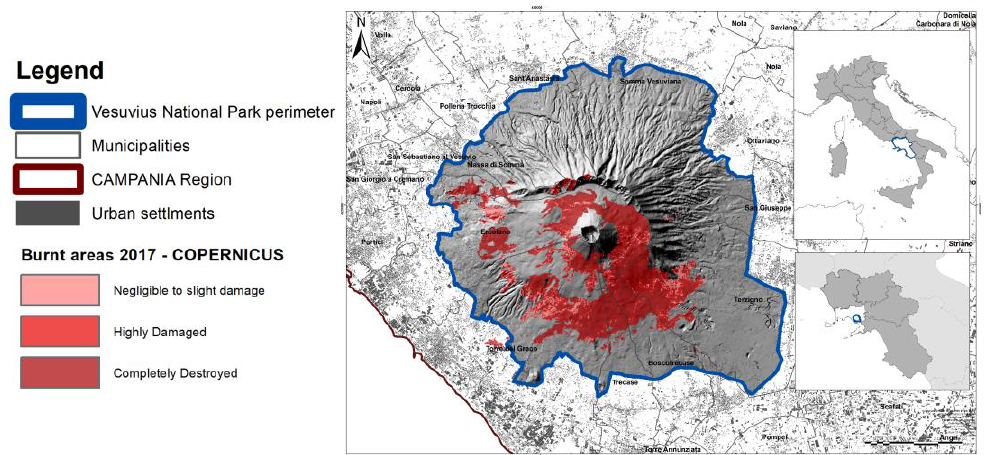
Figure 1. The study area: Vesuvius National Park in Campania (Italy). Non English contents are place names.